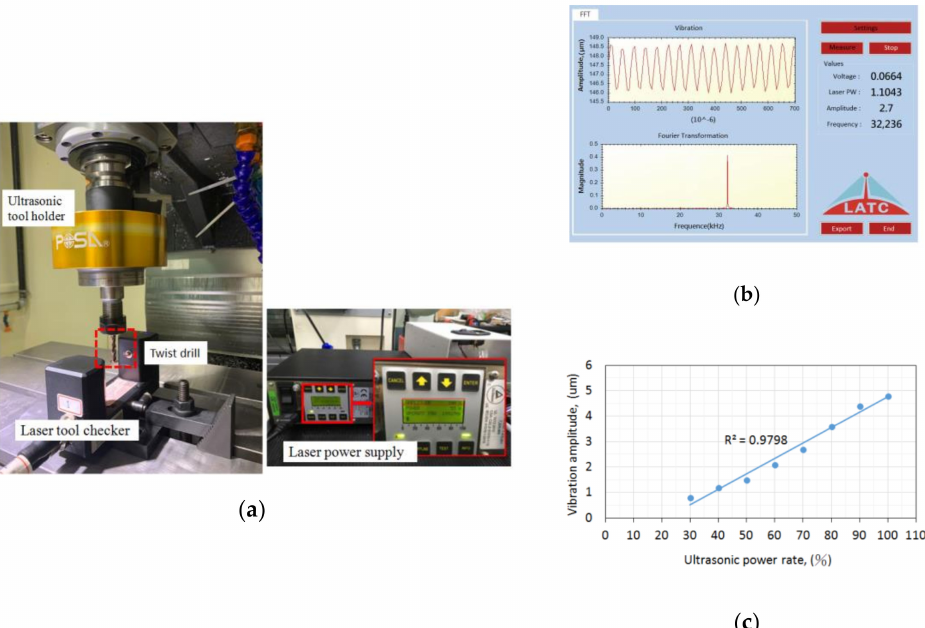
Figure 3. Measurement of the vibration amplitude of the ultrasonic tool holder. ( a ) Ultrasonic tool holder and tool checker with power supply, ( b ) graphic data display interface, ( c ) relationship between vibration amplitude and power rate.